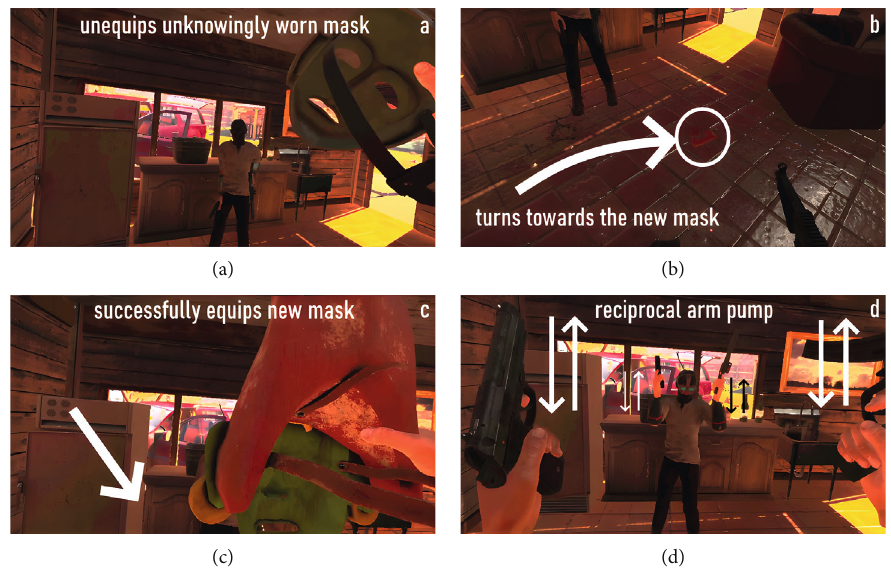
Figure 5: Successful resolution of the search sequence.